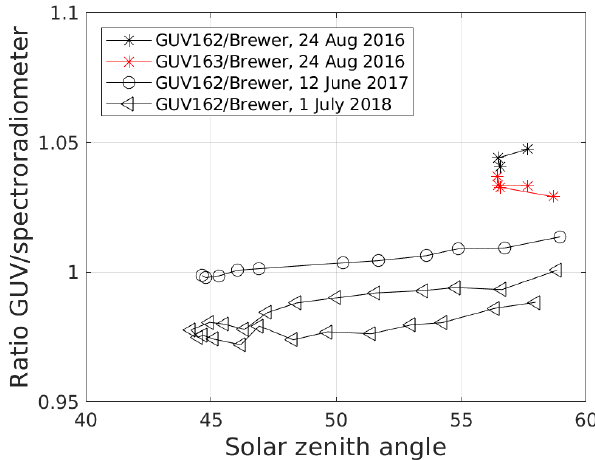
Figure 3. Ratio of the GUV and Brewer spectroradiometer UVB dose rates at Sodankylä.